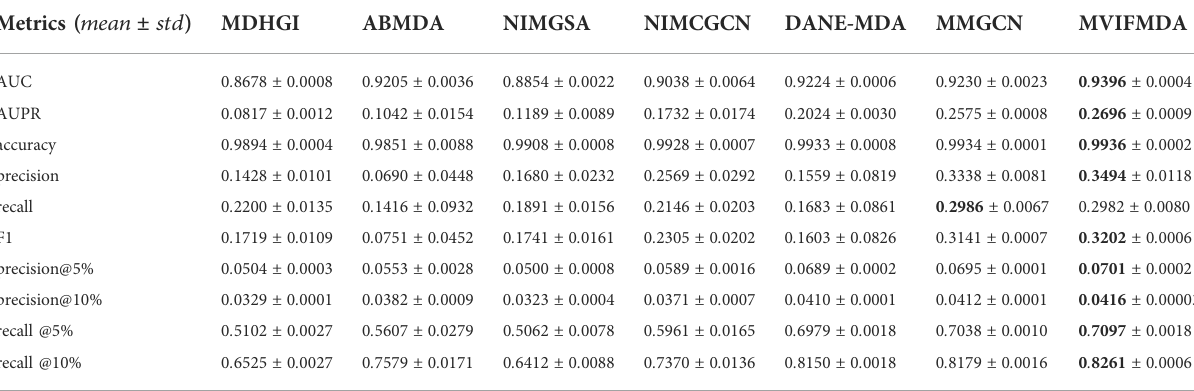
The bold values indicate the best values in rows.